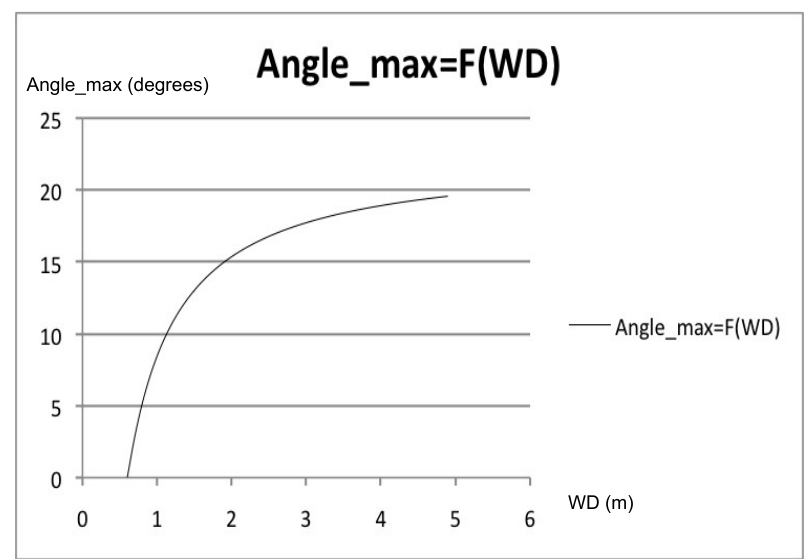
Figure 17. Maximum rotation of the camera in R x or R y